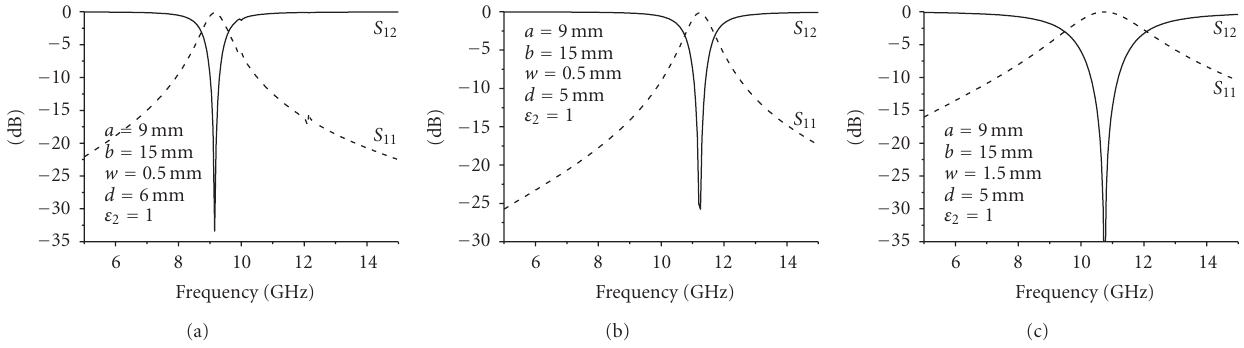
Figure 3: Amplitude-frequency characteristics of the band-rejection element in the case of the quarter-wave resonance.